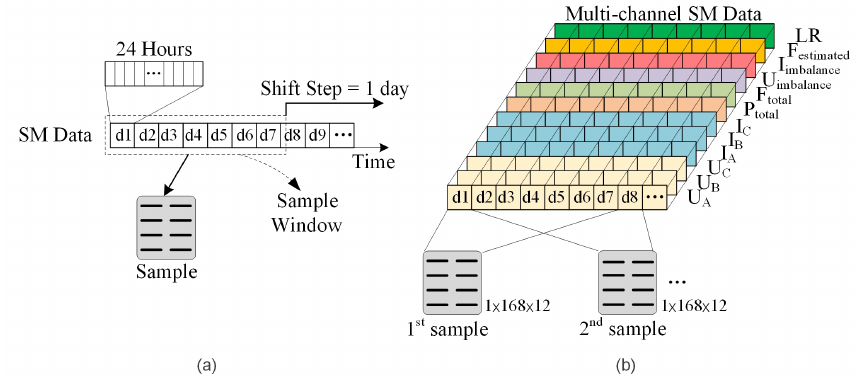
Figure 3. Structure of sample. ( a ) create samples based on shift window. ( b ) sample model embedded by knowledge.